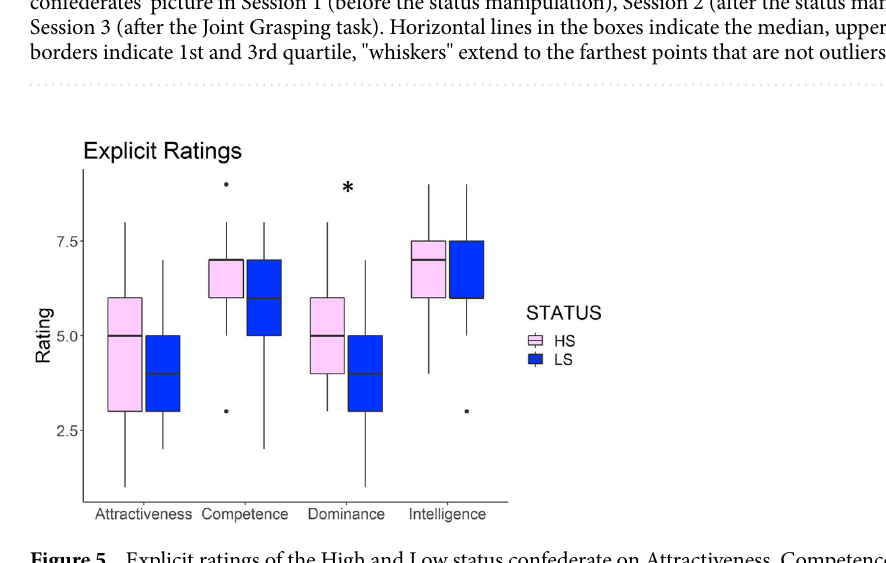
Figure 5. Explicit ratings of the High and Low status confederate on Attractiveness, Competence, Intelligence and Dominance. Asterisks indicate p values: p < 0.05. Horizontal lines in the boxes indicate the median, upper and lower borders indicate 1st and 3rd quartile, "whiskers" extend to the farthest points that are not outliers, dots represent outlier